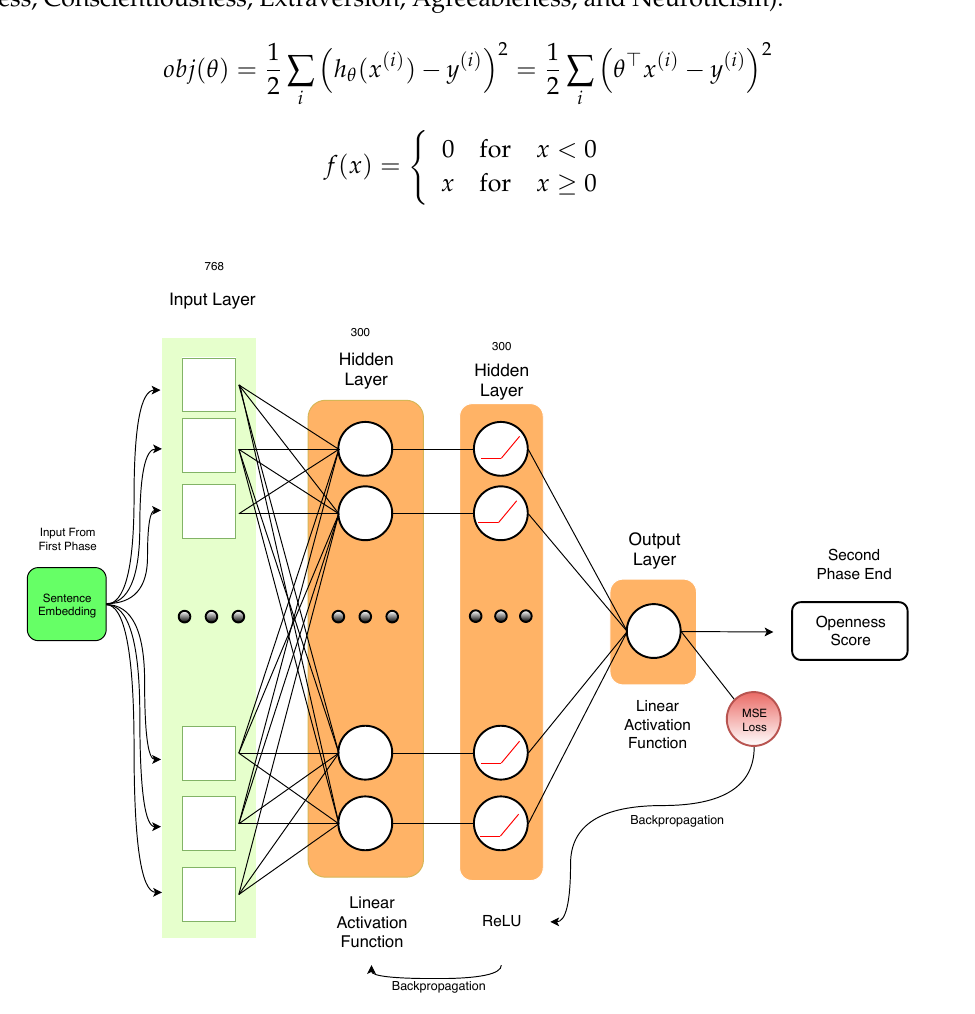
Figure 5. Stacked neural network. Starting from the sentence embedding from the encoding phase, we build a stacked model with two hidden layers with, respectively, a linear activation function in each neuron and then a ReLu. The output layer performs the regression on the personality trait